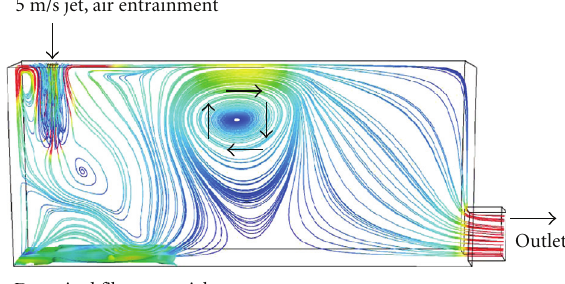
Figure 10: Water flow field induced by the entrained air.